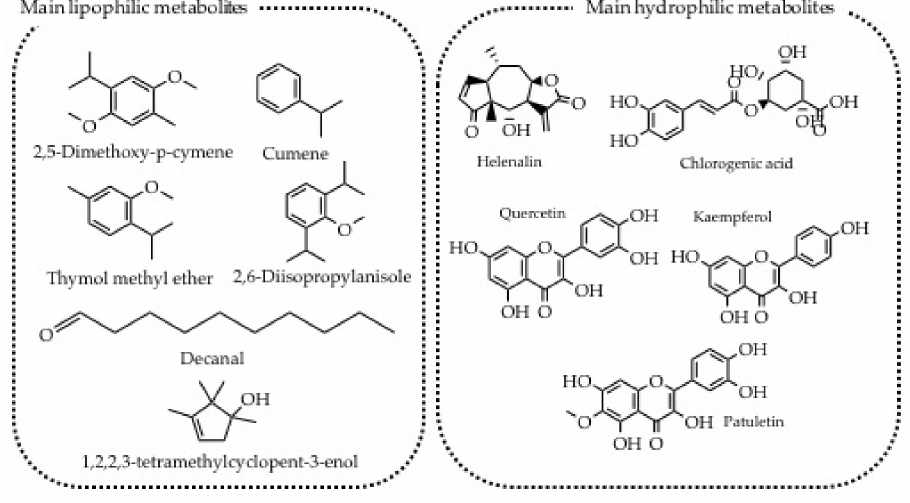
Figure 5. Main secondary metabolites produced by Arnica montana